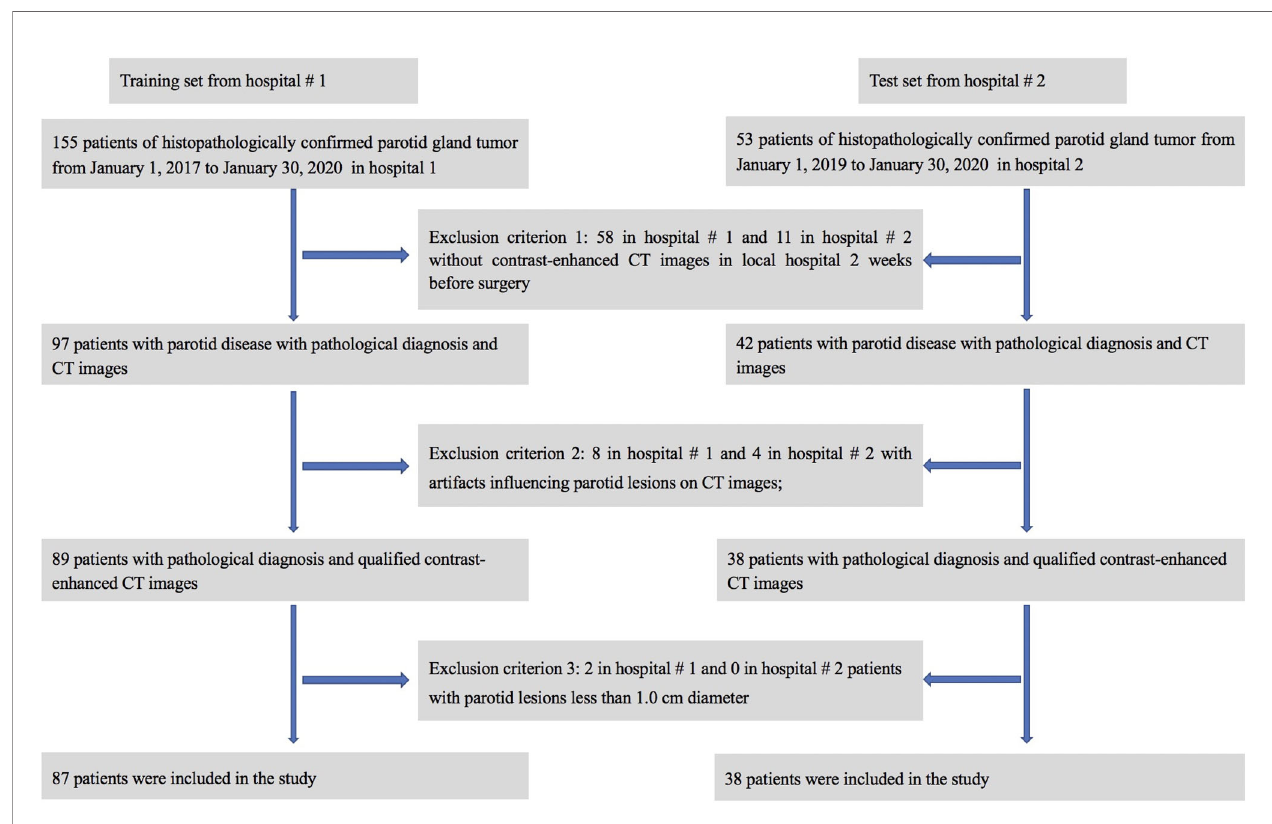
FIGURE 1 | Flow chart for patient selection in this